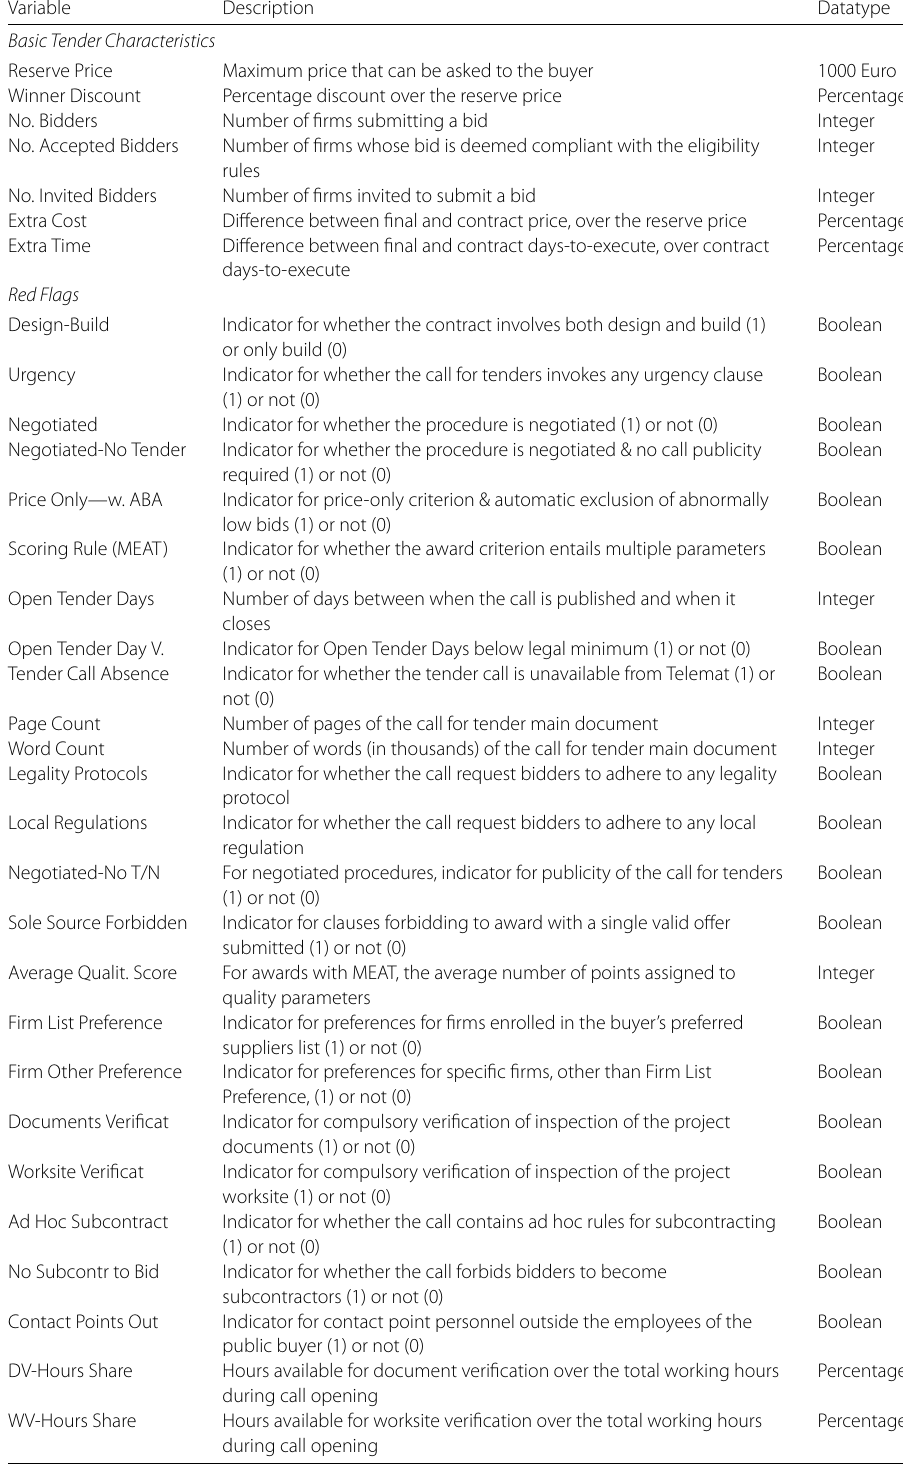
Table A.1 Contract and tender data details Variable